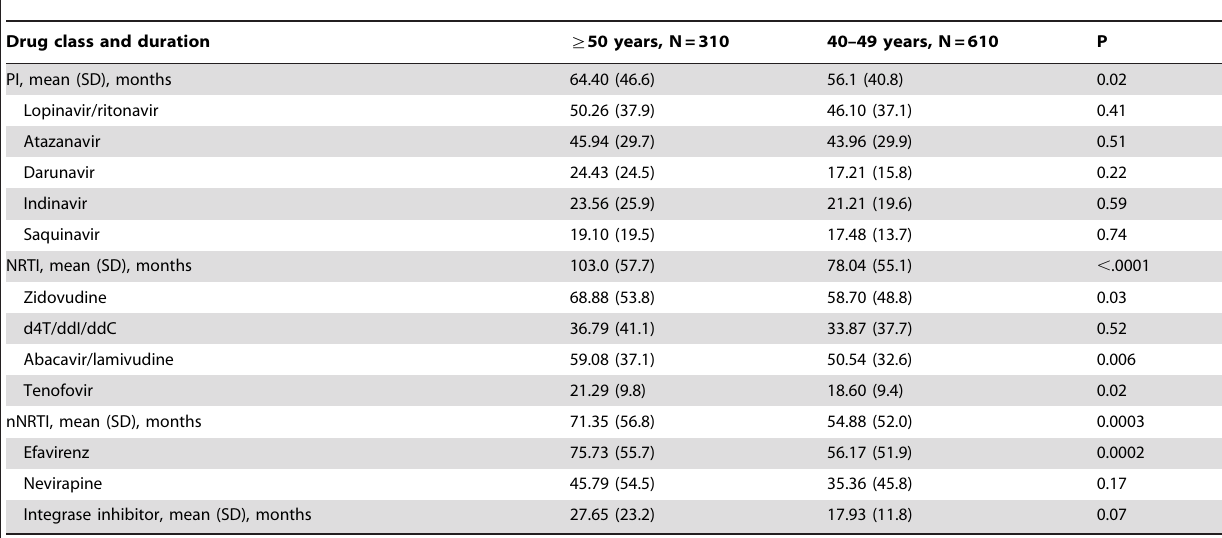
Table 3. The cumulative exposure durations of antiretroviral agents of the two study populations.